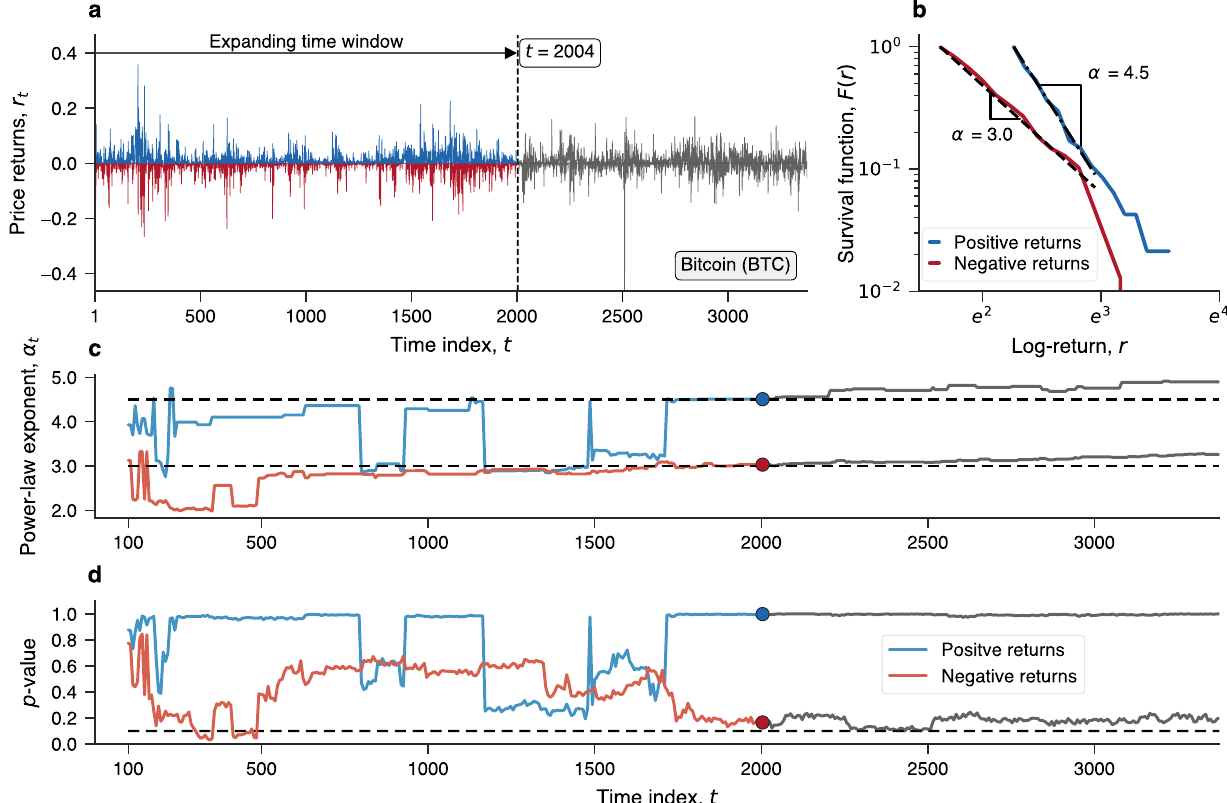
Figure 1. Illustration of the approach used to probe patterns in price returns of digital currencies. ( a ) Bitcoin’s time series of daily returns ( r t ) between 29 April 2013 ( t = 1 ) and 25 July 2022 ( t = 3375 ). The black horizontal arrow represents a given position of the expanding time window (at t = 2004 days) used to sample the return series over the entire history of Bitcoin. This time window expands in weekly steps (seven time series observations), and for each position, we separate the positive (blue) from the negative (red) price returns. The gray line illustrates observations that will be included in future positions of the expanding time window ( t > 2004 ). ( b ) Survival functions or the complementary cumulative distributions of positive (blue) and negative (red) price returns within the expanding time window for t = 2004 days and above the lower bound of the power-law regime estimated from the Clauset-Shalizi-Newman method 40 . The dashed lines show the adjusted power-law functions, p ( r ) ∼ r − α , with α = 4.5 for positive returns and α = 3.0 for negative returns. ( c ) Time series of the power-law exponents α t for the positive (blue) and negative (red) return distributions obtained by expanding the time window from the hundredth observation ( t = 100 ) to the latest available price return of Bitcoin. The circular markers represent the values for the window position at t = 2004 days and the dashed lines indicate the median of the power-law exponents ( ˜ α + = 4.50 for positive returns and ˜ α − = 2.99 for negative returns). ( d ) Time series of the p -values related to the power-law hypothesis of positive (blue) and negative (red) price returns for every position of the expanding time window. The dashed line indicates the threshold ( p = 0.1 ) above which the power-law hypothesis cannot be rejected. For Bitcoin, the power-law hypothesis is never rejected for positive returns (fraction of rejection f r = 0 ) and rejected in only 4% of the expanding time window positions for negative returns (fraction of rejection f r = 0.04